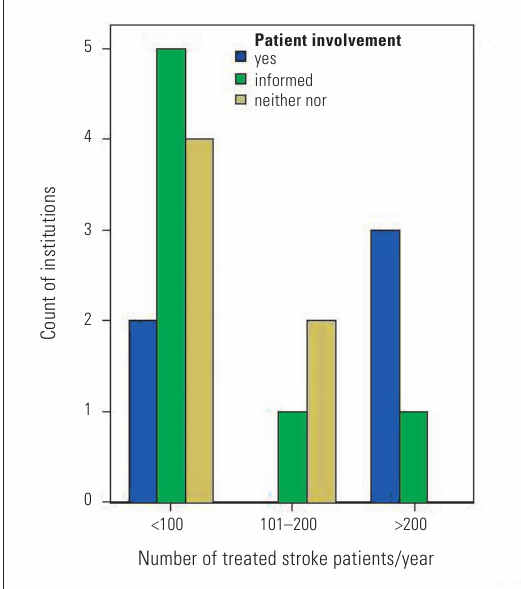
Figure 3 Patients’ involvement and number of treated stroke patients/year.